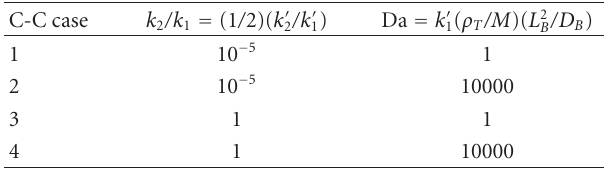
Table 5: Numerical values for simulated C-C test cases. Stoichio- metric coe ffi cients α , β , γ , and (cid:2) were set to 1, representing the k (cid:2) 1 −→ P k (cid:2) 2 −→ S , P + B , and the initial mass fraction of reaction: A + B = species B was always 1 ( w B 0